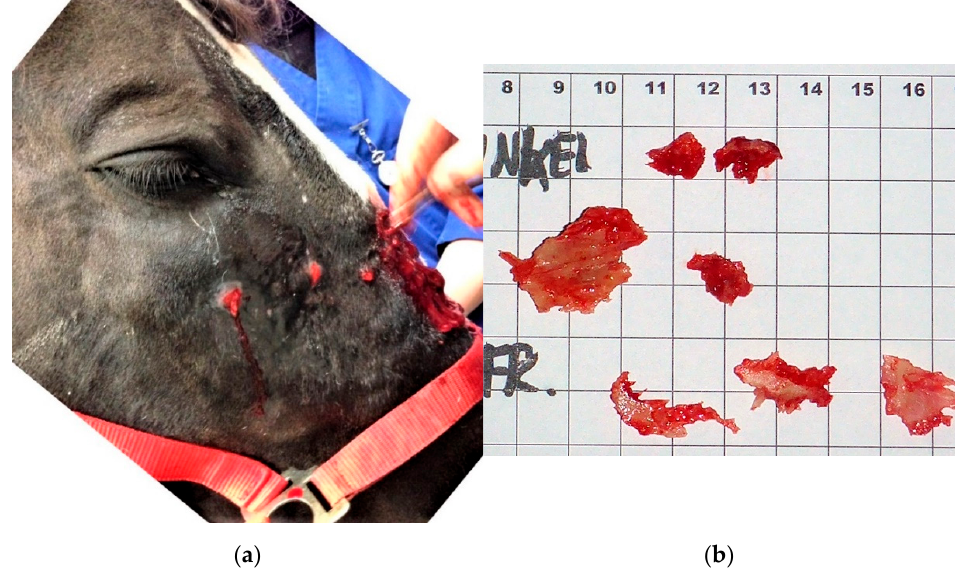
Figure 8. ( a , b ): Surgical debridement and sequestrectomy in a horse with moderate suture exostosis forming purulent abscesses after bone flap surgery.